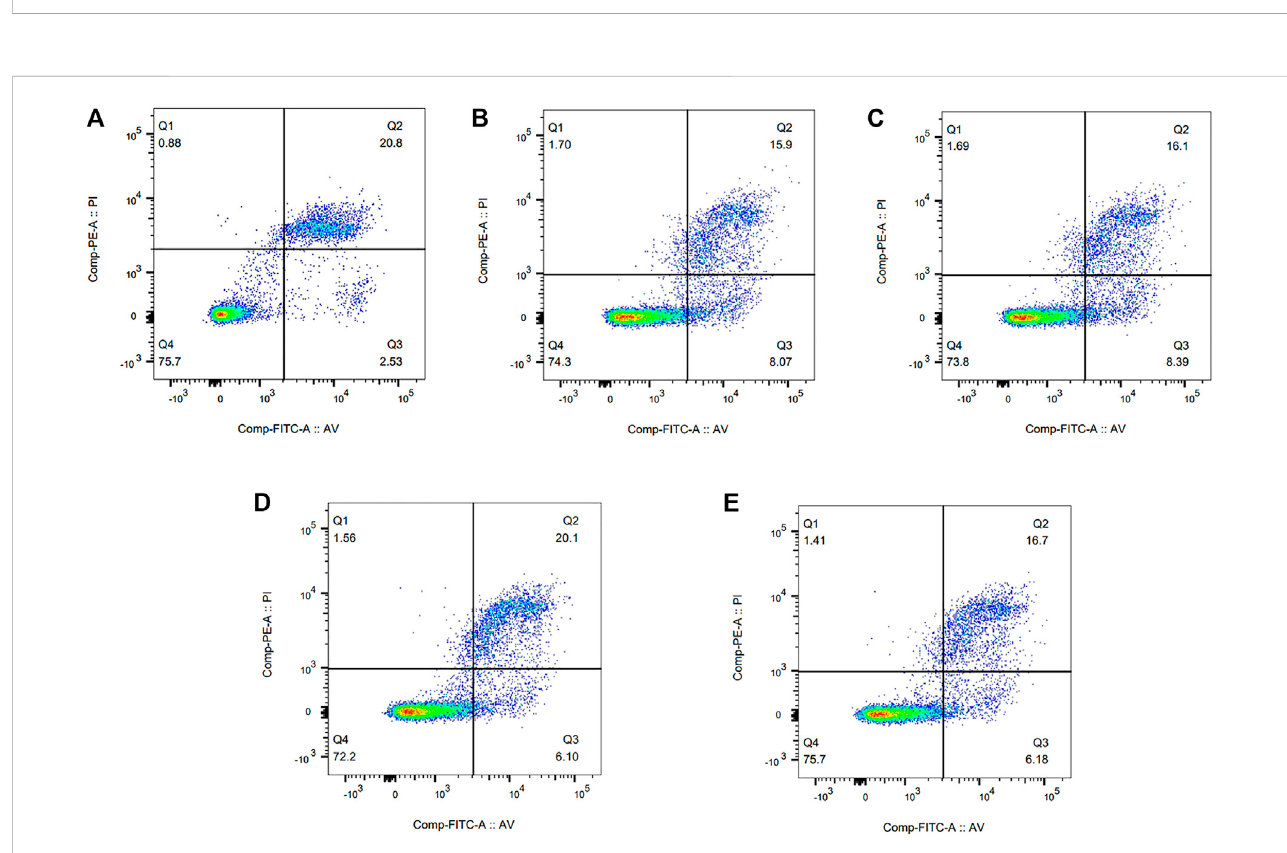
Flow cytometry results of RAW264.7 cultured with the extracts for 24 h. (A) PU, (B) PDA, (C) PU-0.25Cu, (D) PU-0.5Cu, and (E) PU-1Cu.